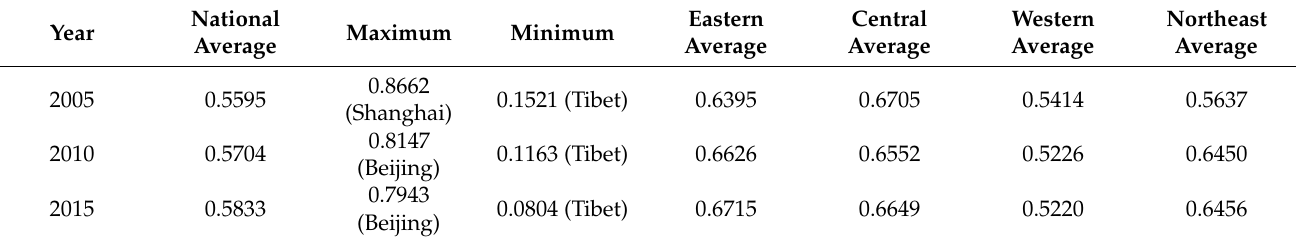
Table 3. Descriptive statistics of quality-of-life index for the oldest-old in